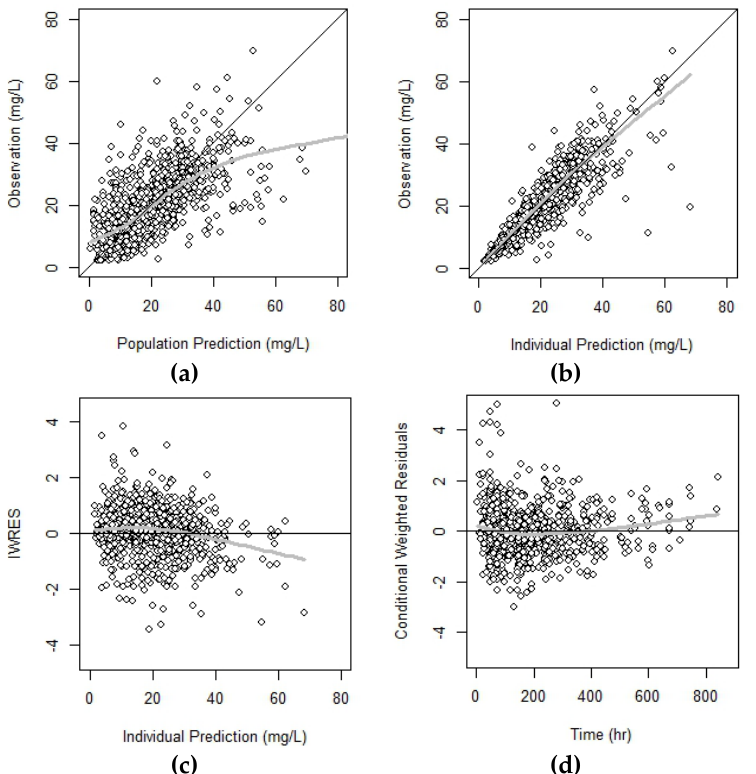
Figure 1. The basic goodness-of-fit plot for the vancomycin pharmacokinetic model. ( a ) Observations versus population predictions, ( b ) observations versus individual predictions, ( c ) individually weighted residuals versus individual predictions, and ( d ) conditional weighted residuals versus time. The solid black y = x or y = 0 lines are the line of identity and the line of reference, respectively. The solid gray lines are the lines of locally weighted scatterplot smoothing (LOWESS), and IWRES refers to the absolute value of individual weighted residuals. Table 2. Final estimates of population pharmacokinetic parameters.